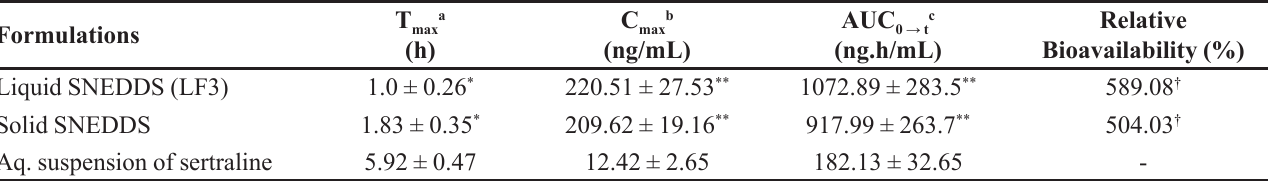
TABLE VI - Relative bioavailability and pharmacokinetics parameters after oral administration of liquid (LF3) and solid SNEDDS, aqueous suspension of plain sertraline. All values reported are mean ± SD (n = 3)